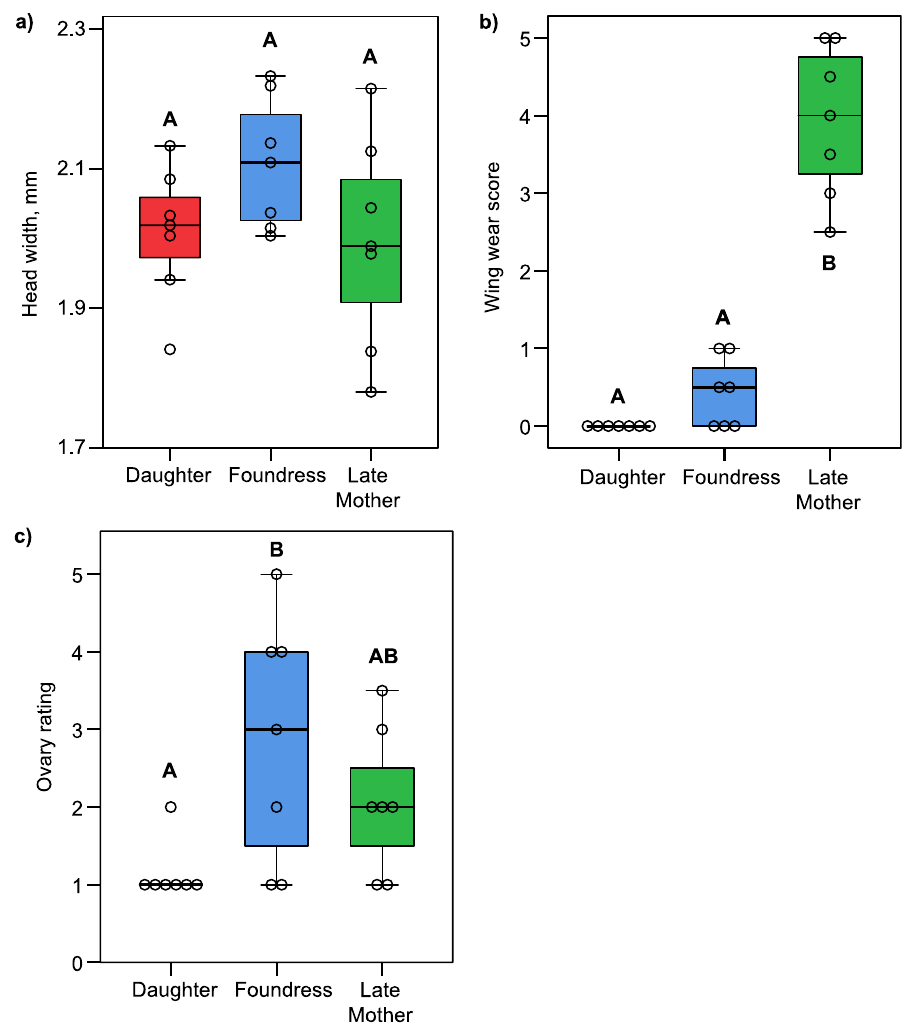
Figure 2. Boxplots showing head width, a measure of body size ( a ), wing wear ( b ) and ovary development ( c ) among newly emerged daughters, foundresses, and late mothers. N = 7 for each group. Note that no newly emerged daugthers exhibited wing wear, and only one exhibited ovarian development. Groups that do not share a letter are significantly different from each other based on ANOVA ( a ) or Kruskil-Wallis test followed by Bonferroni-corrected pairwise comparisons ( b , c